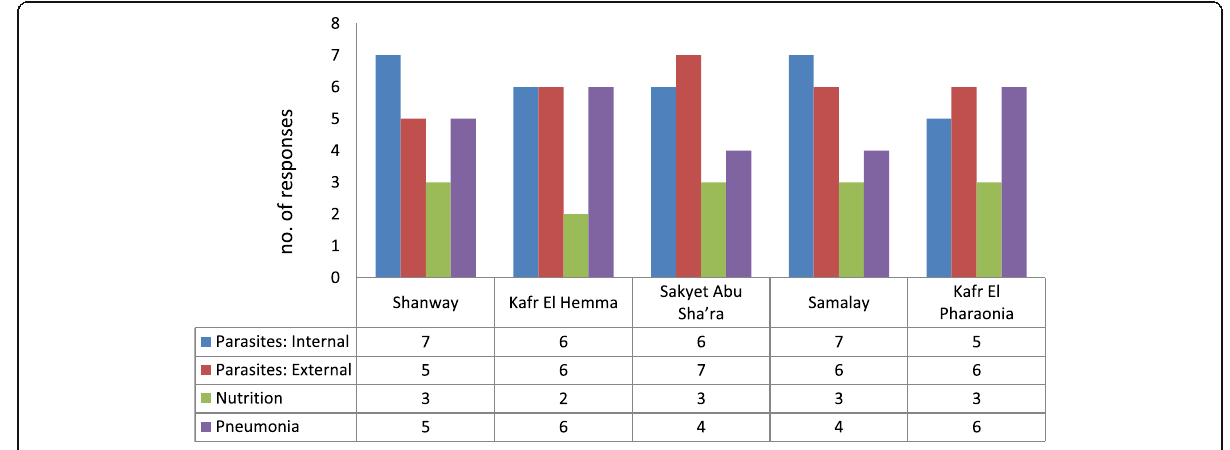
Fig. 3 Importance of goat diseases in rural areas of the Nile Delta in Egypt